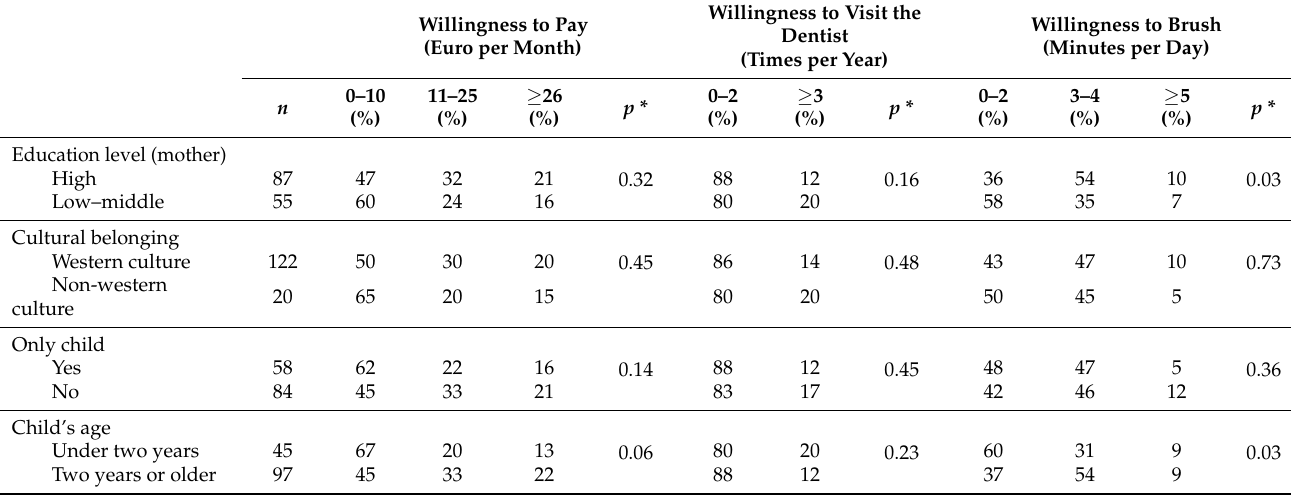
Table 4. Distribution (%) of socio-demographic variables by the willingness to invest in children’s oral health.